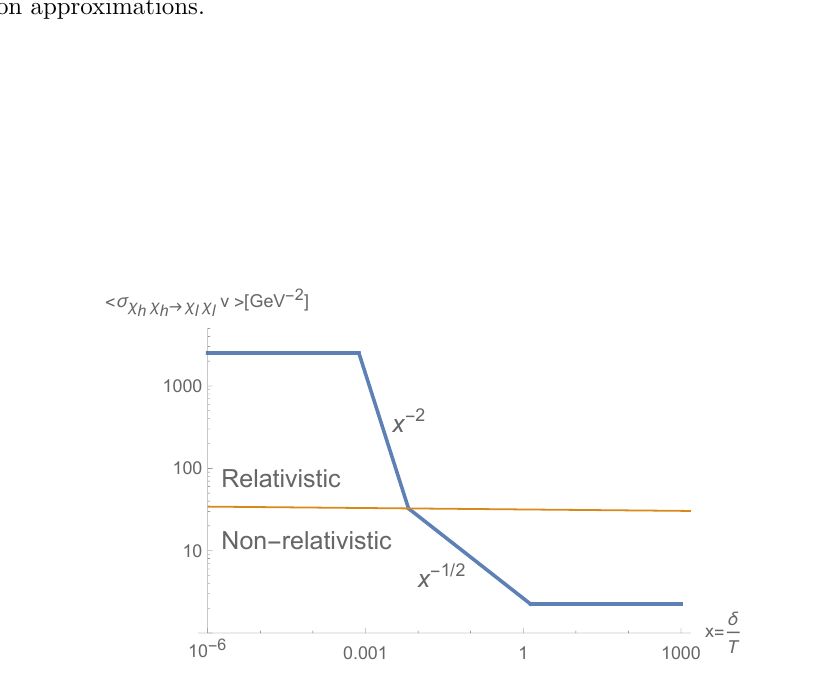
= 10 MeV, m = 5 m , δ = 10 − 2 MeV, and dark coupling α A 0 χ l l